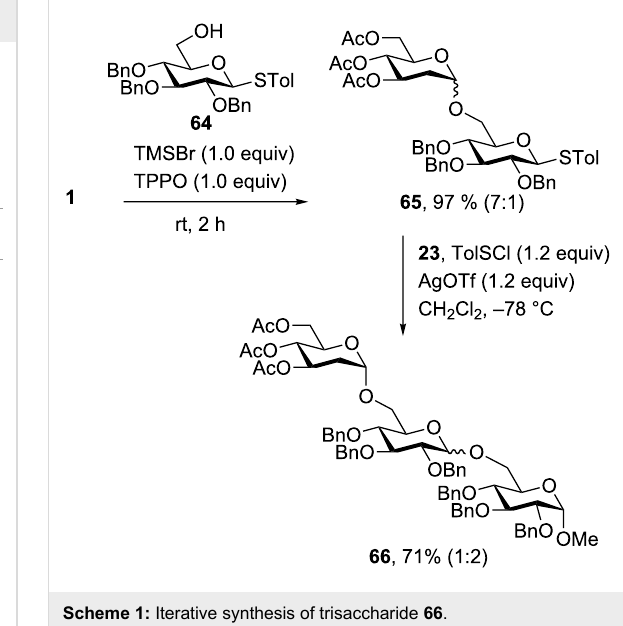
Scheme 1: Iterative synthesis of trisaccharide 66